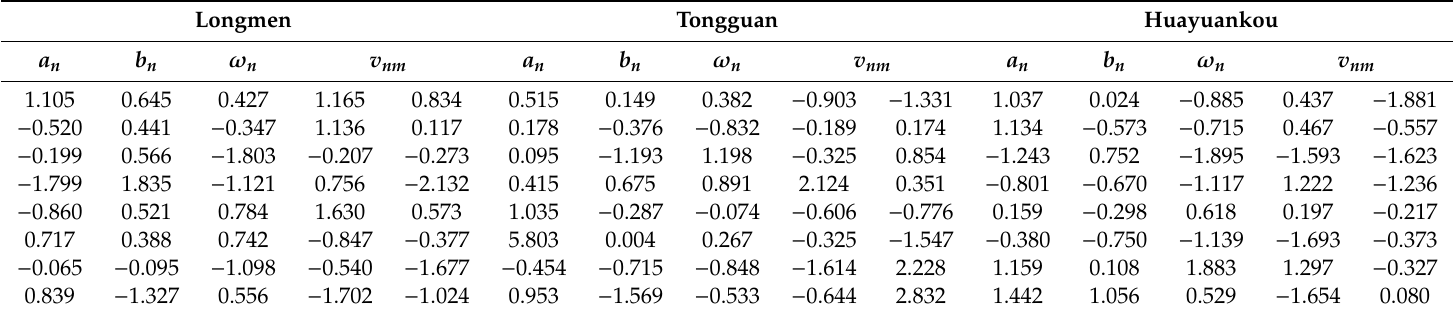
Table 9. Related parameters of SL − runo ff cointegration